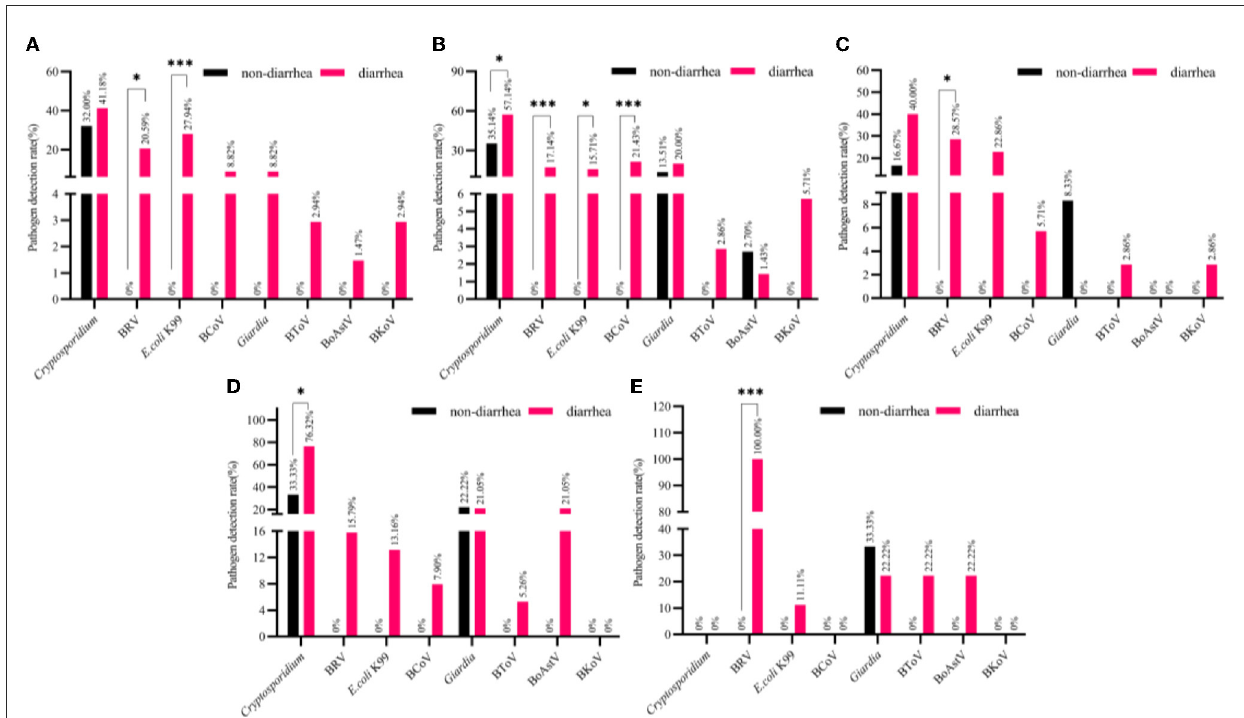
FIGURE3 The detection rate of normal and diarrhea samples in different cities [ (A) Yinchuan, (B) Wuzhong, (C) Shizuishan, (D) Zhongwei, (E) Guyuan]. The number of pathogen detection and non-detection in normal stool samples with the number of pathogen detection and non-detection in diarrhea stool samples in different cities were counted for chi-square test (mean ± standard deviation) *** p < 0.01, * p <